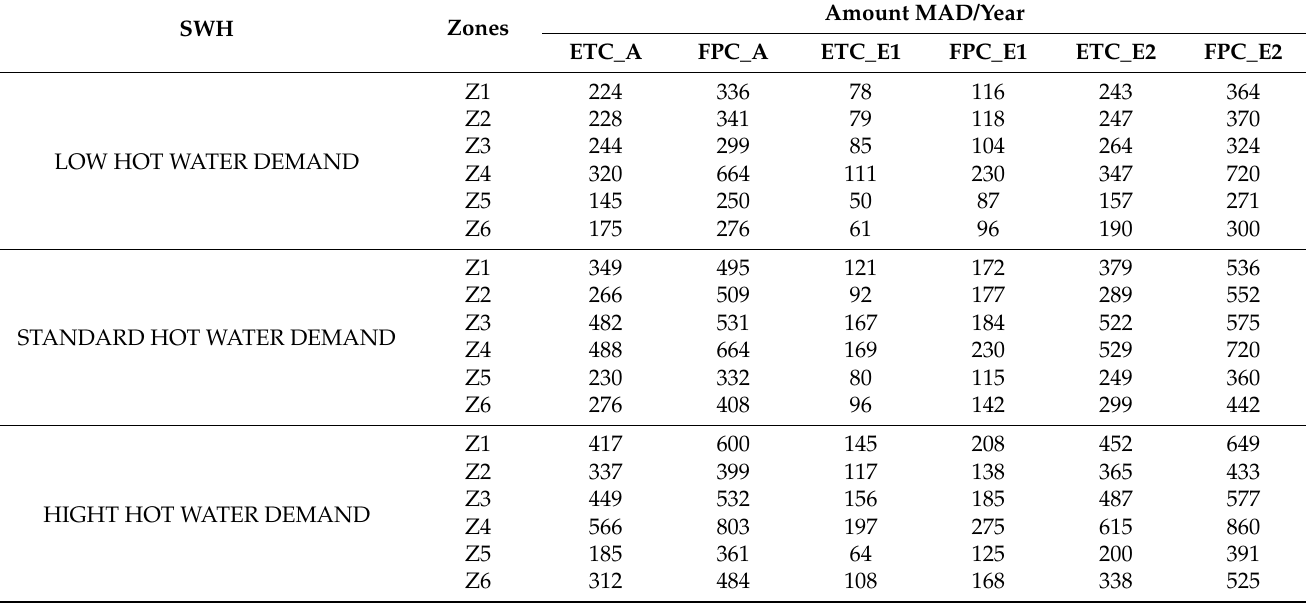
Table 14. Energy bill of auxiliary